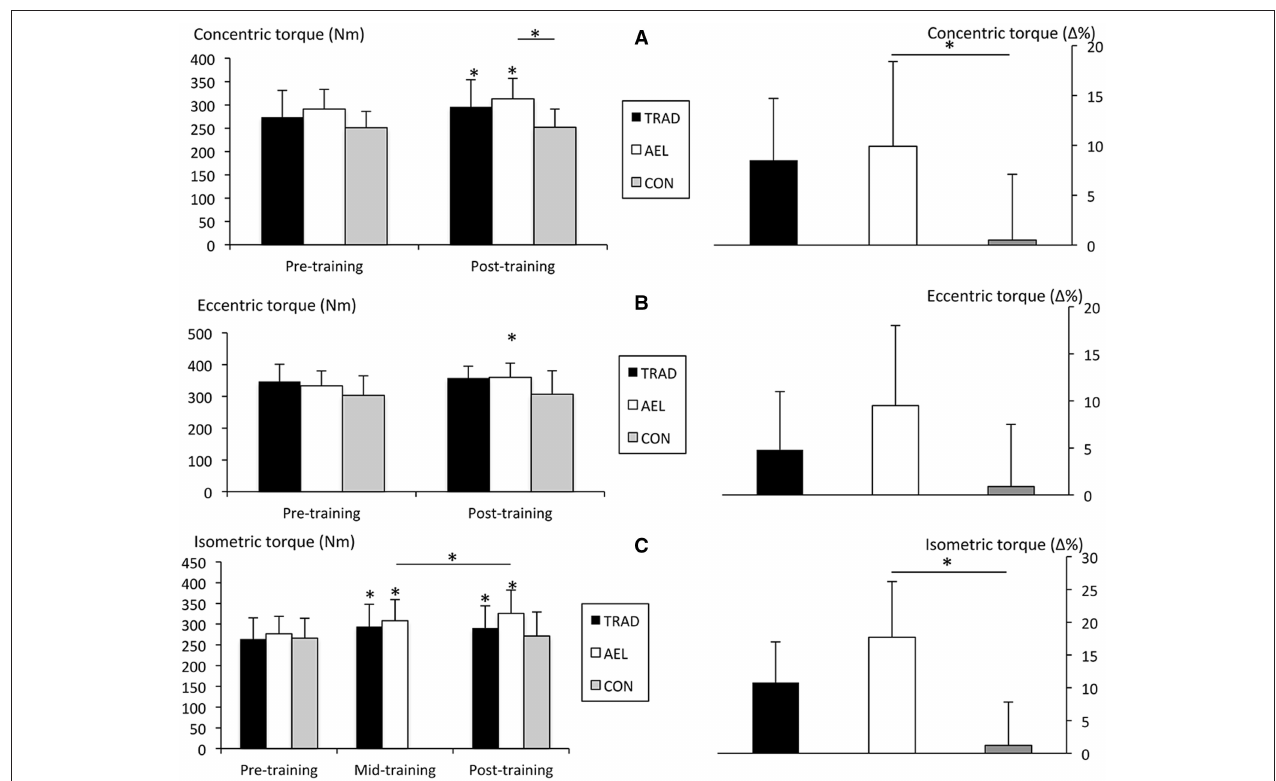
FIGURE 3 | Absolute and relative changes (mean ± SD ) in maximum unilateral isokinetic concentric (A—top panel), eccentric (B—middle panel), and isometric (C—bottom panel) torque production. * p < 0.05.